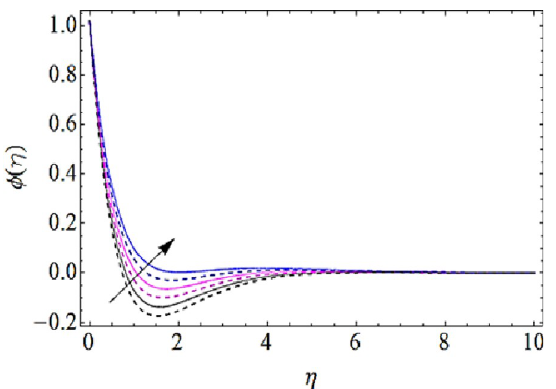
Fig 13. Concentration characteristics for various values of Brownian motion